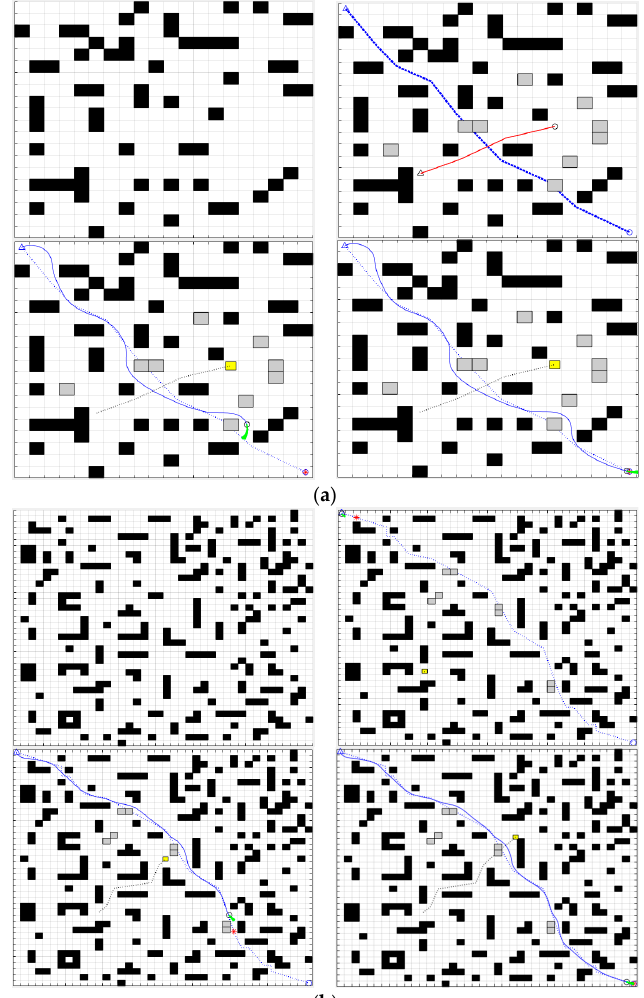
Figure 10. Simulation experiments of A-OP fusion algorithm. ( a ) simple environment, ( b ) com- plex environments.